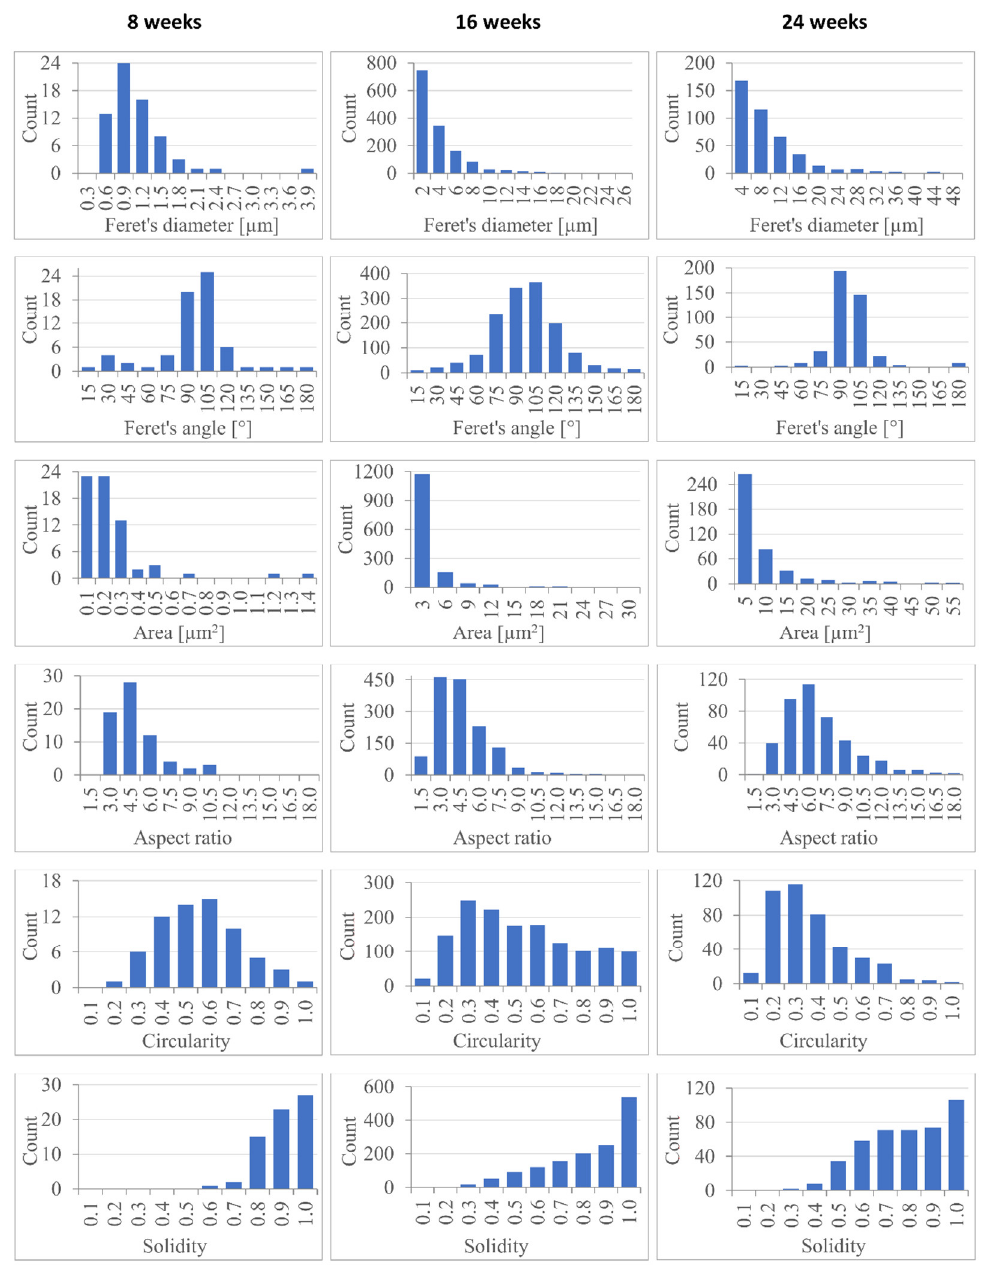
Figure 5. Histograms describing sizes and shapes of cracks observed on the stent surface after 8, 16 and 24 weeks of degradation. Table 2. Morphological characteristics of the cracks.